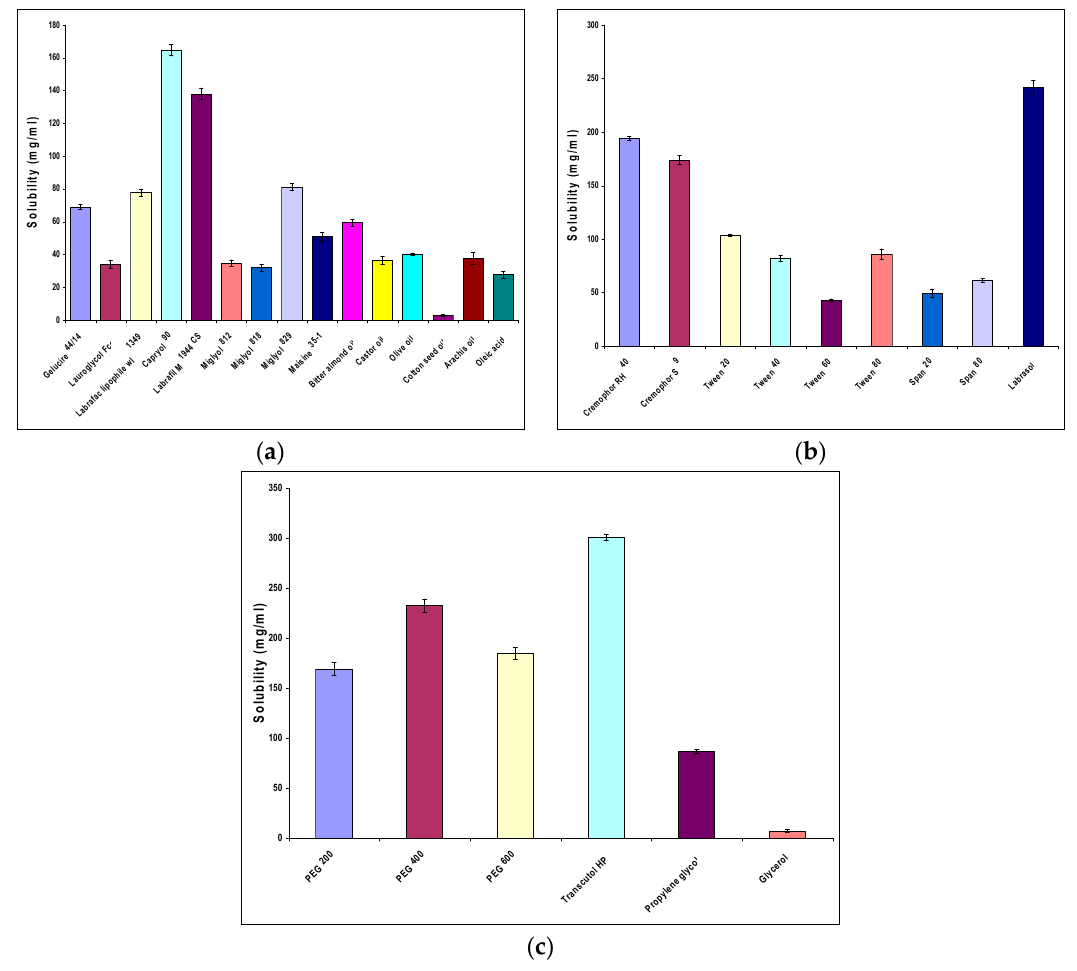
Figure 2. Solubility of OLM ( a ) in various oils; ( b ) in various surfactants; ( c ) cosurfactants.